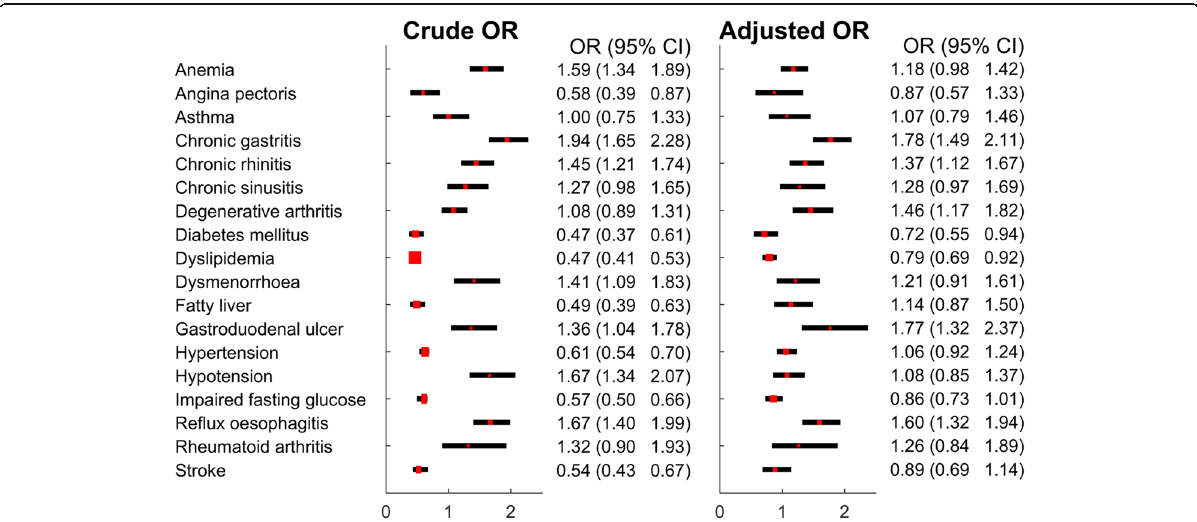
Fig. 2 The odds ratios (ORs) and 95% confidence intervals (CIs) for diseases according to CHHF status. Logistic regression analysis, adjusted for sex, age, and body mass index. CHHF: cold hypersensitivity in the hands and feet; ref.: reference. “ Non-CHHF ” was employed as the reference in every